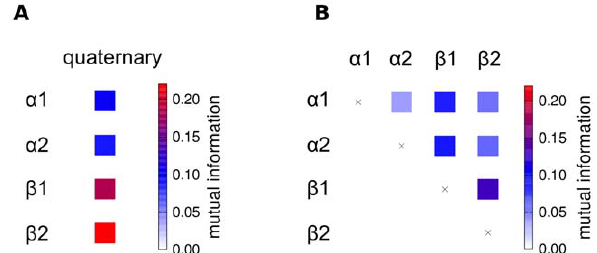
Figure 6. (A) Correlation between quaternary and tertiary transitions as averaged from six independent T R R transitions, and (B) correlation between subunits during T R R transitions. The correlation is measured using the mutual information (MI) between the projections on the respective difference vectors connecting the T and the R X-ray